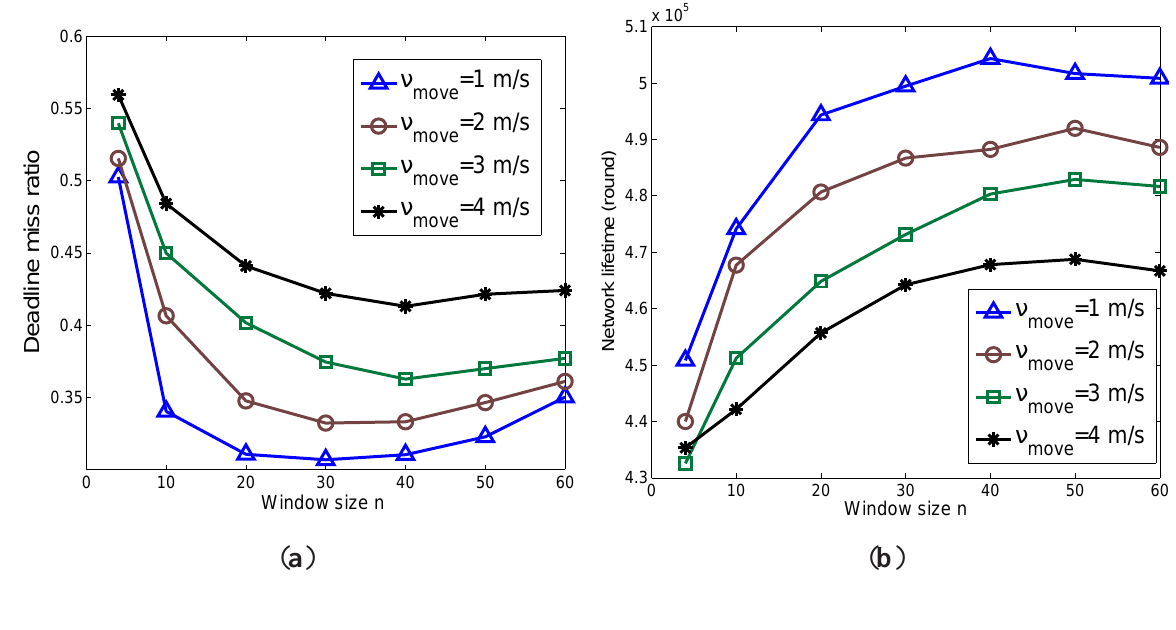
Figure 16. The effect of n and ν Network lifetime (GW-B).